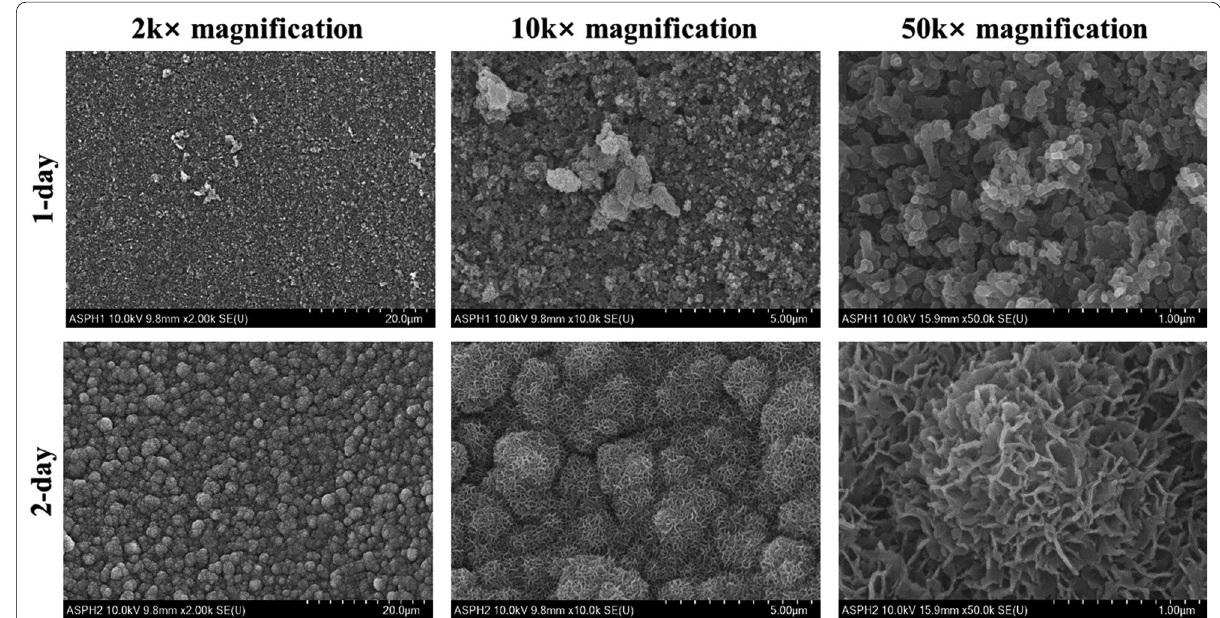
Fig. 7 FE‑SEM images of the surface of a Ti–6Al–4V ELI alloy mini‑screw of the APH group immersed in SBF for 1 and 2 days